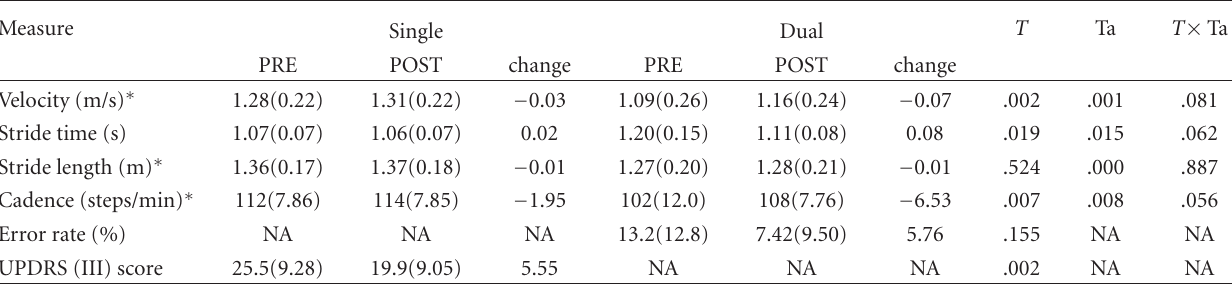
Table 3: Summary of descriptive statistics and change scores for the MUSIC group for outcome measures pre- and post-intervention.